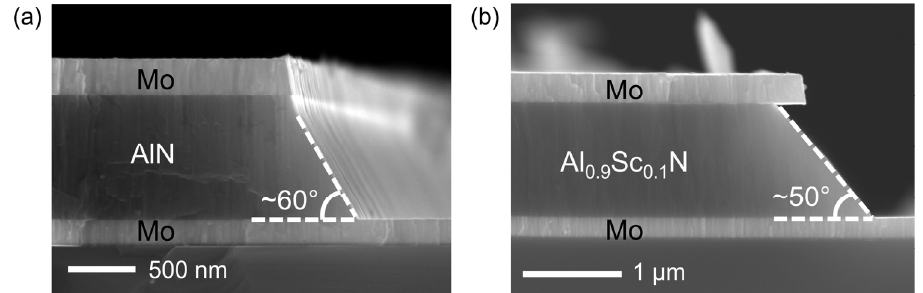
Figure 4. Cross ‐ section SEM images of ( a ) AlN and ( b ) Al 0.9 Sc 0.1 N piezoelectric stacks. Figure 4. Cross-section SEM images of ( a ) AlN and ( b ) Al 0.9 Sc 0.1 N piezoelectric